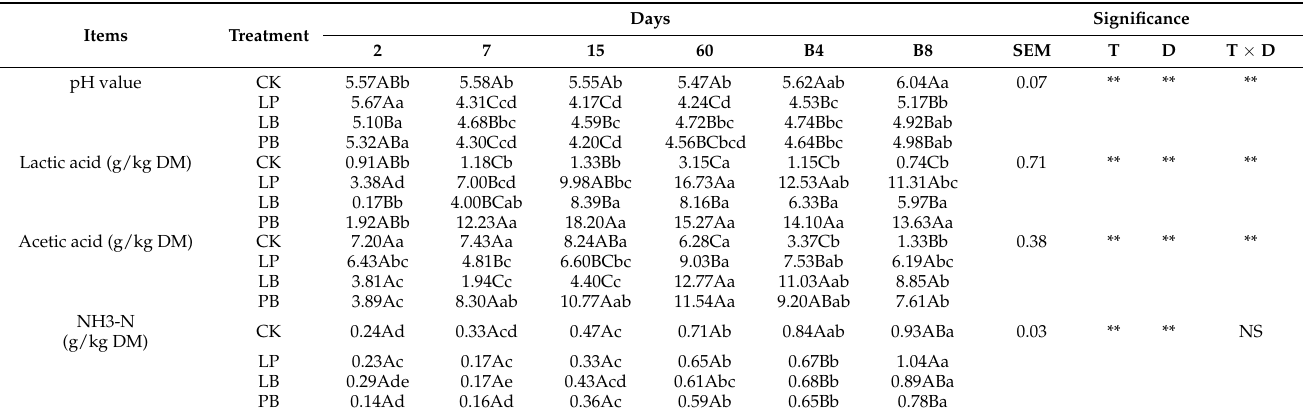
Table 3. Effects of additives and days of anaerobic fermentation and aerobic exposure on fermentation quality of native grass